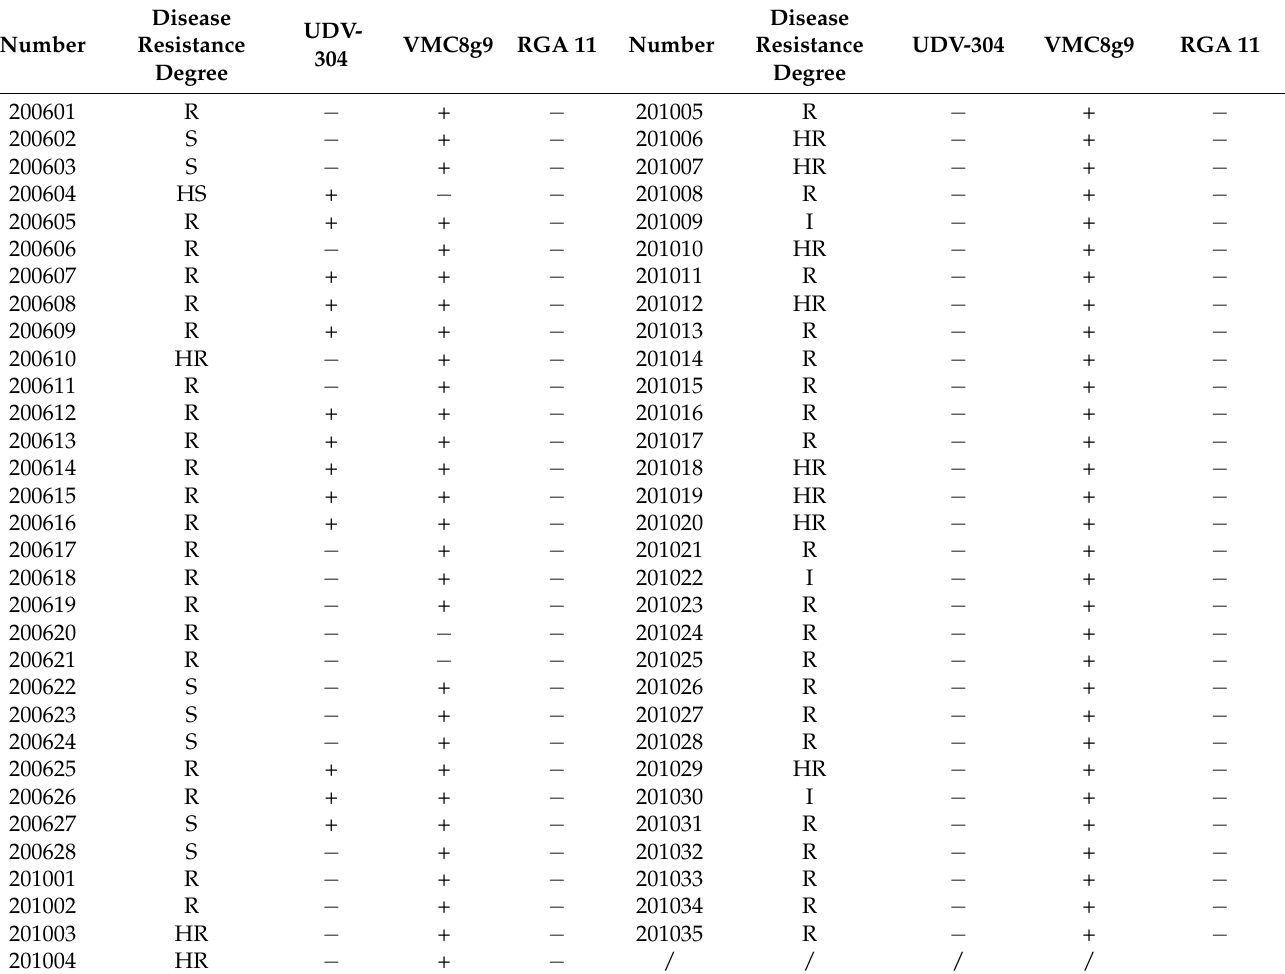
Table 6. Amplification results of two markers in the hybrid F 1 population of combination